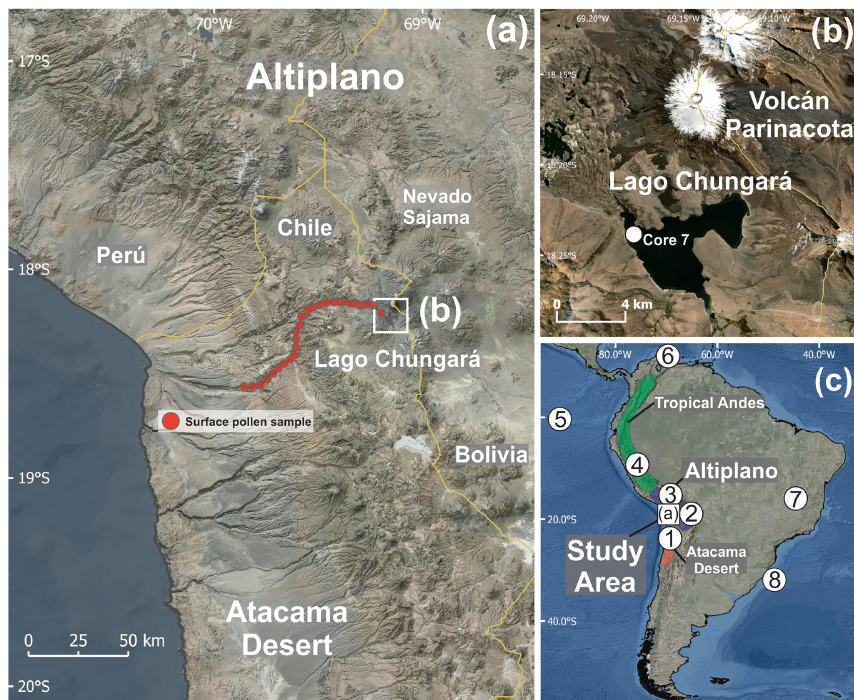
Figure 1. Physiography aspects of the study area. (a) Digital elevation model (DEM) of the southern Altiplano and the southern Atacama Desert depicting the position of Lago Chungará, the surface pollen transect, and the Nevado Sajama. (b) Satellite image of Lago Chungará and Volcán Parinacota showing the position of core 7. (c) South America map with the location of climate reconstructions mentioned in the text: (1) Quebrada Maní and Salar del Huasco, (2) Chiflonkhakha cave system, (3) Lago Titicaca, (4) Lago Junín and Laguna Pumacocha, (5) El Junco Crater Lake, (6) Cariaco Basin, (7) Lapa Grande Cave, (10) core